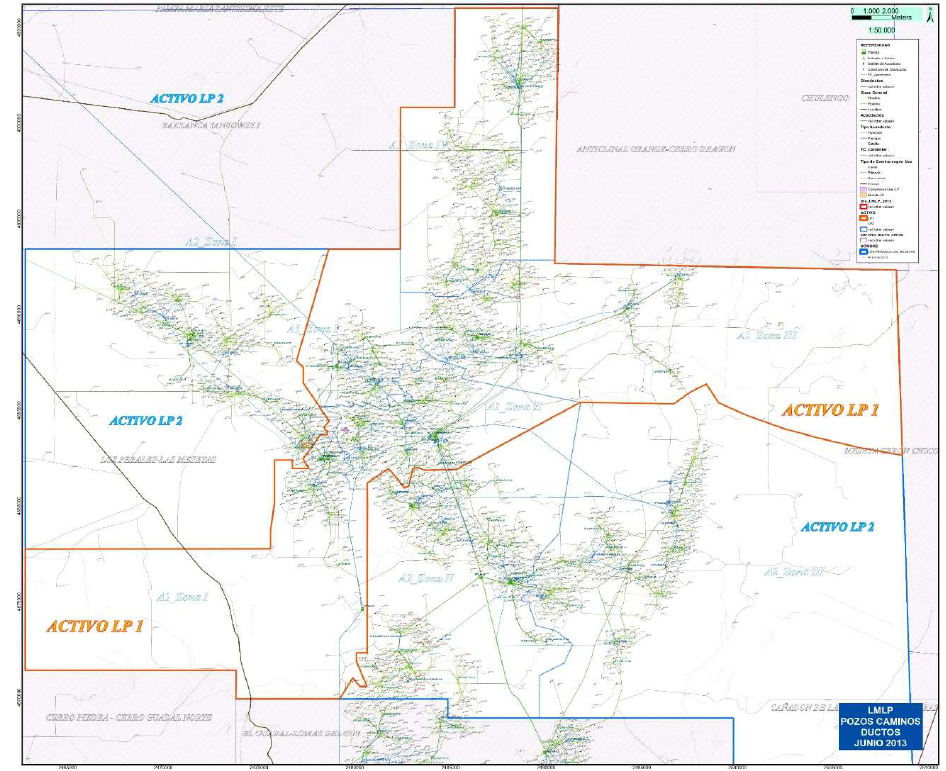
Fig. 1. Map of area under